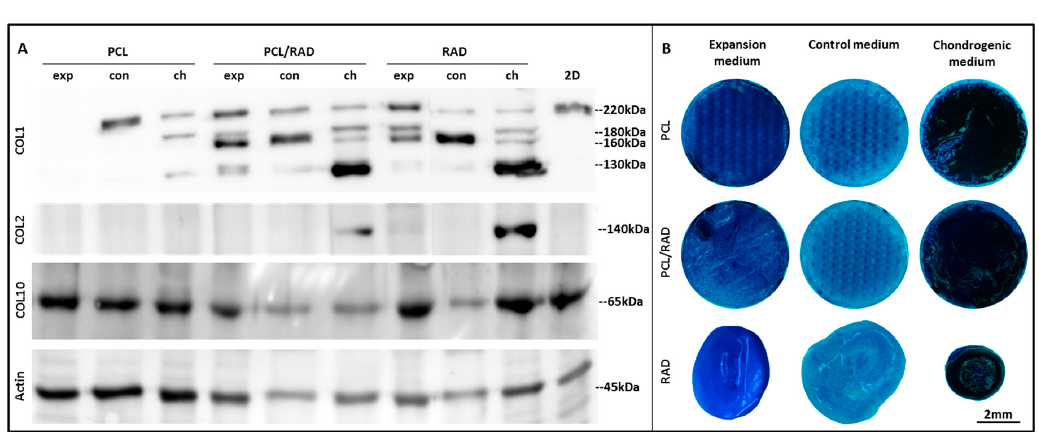
Figure 4. Protein expression characterization of Articular Chondrocytes (AC) cultured in the 3D scaffolds after 4 weeks of culture. ( A ) Western blot results of collagen type I, II and X when AC were maintained in expansion (exp), control (con) and chondrogenic (ch) media in the different scaffolds (PCL, PCL/RAD, and RAD) and in monolayer. Actin expression was used as an internal control. Samples were prepared in triplicate; ( B ) Toluidine blue staining of AC seeded into PCL, PCL/RAD, and RAD scaffolds cultured in expansion, control and chondrogenic media.